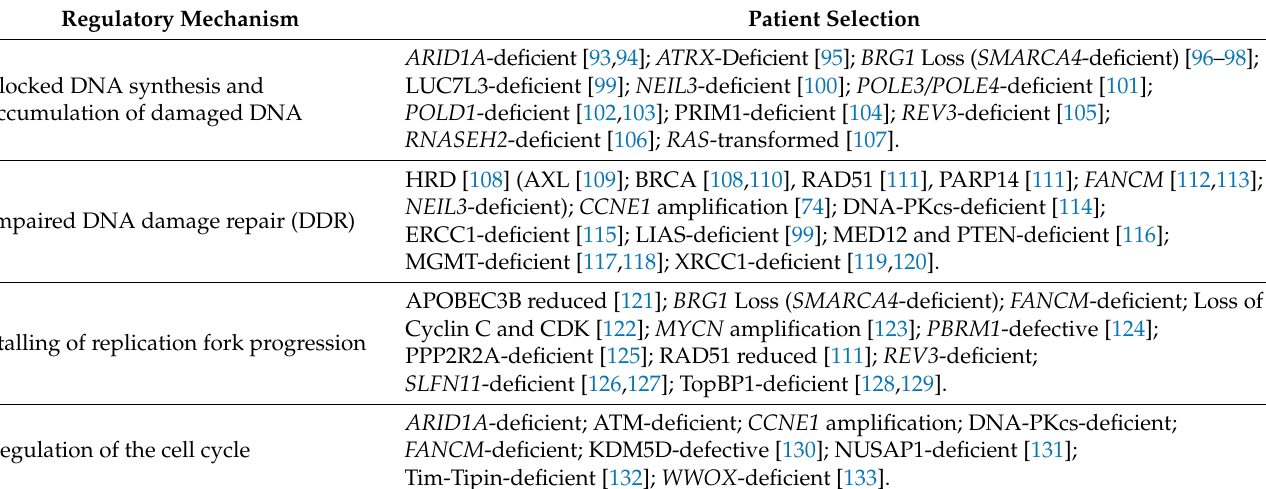
Table 2. Potential biomarkers of ATR